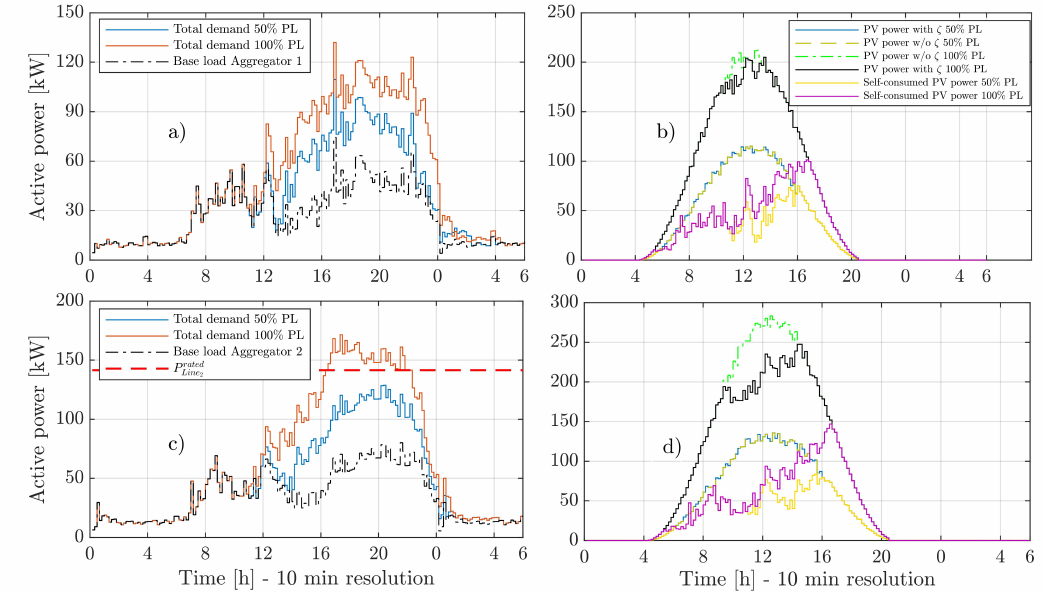
Figure 5. Comparison of active power demand and generation for a moderate and critical penetration level (PL). ( a , b ) aggregator 1 and ( c , d ) aggregator